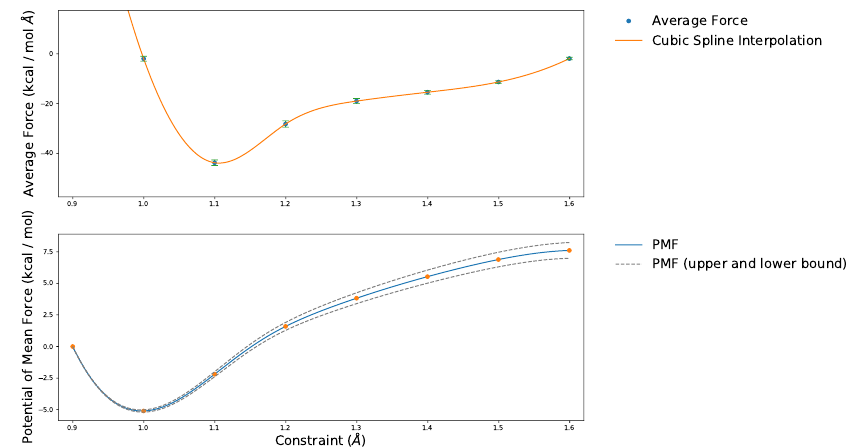
Figure 1. ( top ): Average force ( (cid:104) λ (cid:105) ) acting on the constraint for the PhOH model system, constraining the A–H bond. ( bottom ): Potential of mean force, i.e., free energy obtained by integrating the average